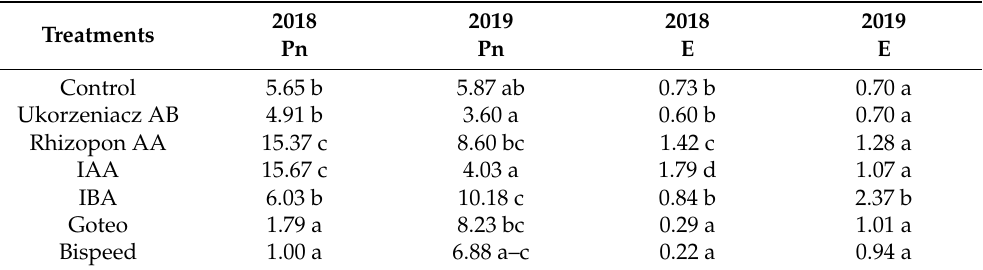
Table 6. Net leaf photosynthesis level (Pn, µ mol CO 2 · m − 2 · s − 1 ) and leaf transpiration